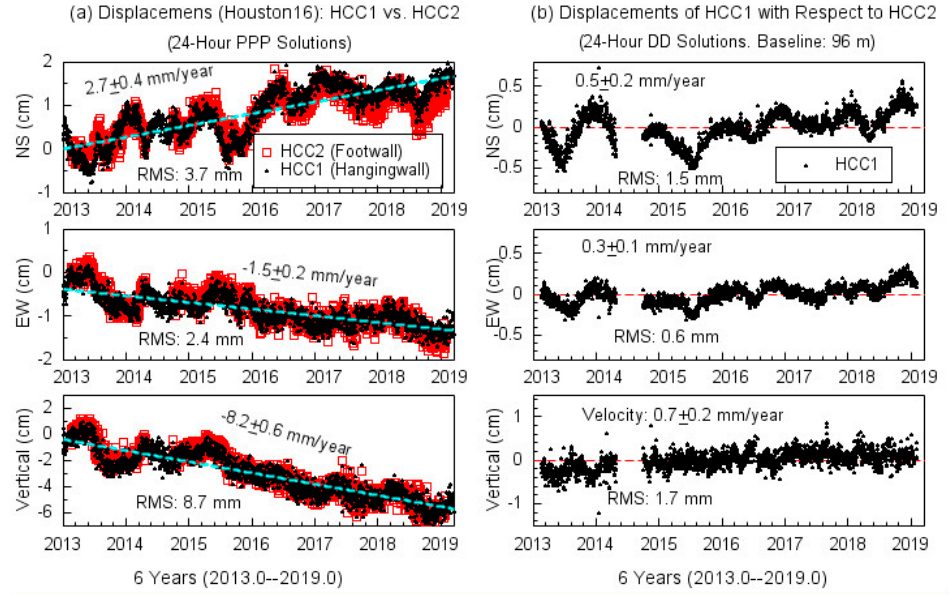
Figure 8. ( a ) The displacement time series of HCC1 and HCC2 (24-hour PPP solutions) with respect to the stable local reference frame Houston16; ( b ) the three-component displacement time series of HCC1 (24-hour DD solutions) with respect to HCC2. The root-mean-square (RMS) accuracy is calculated from detrended displacement time series.